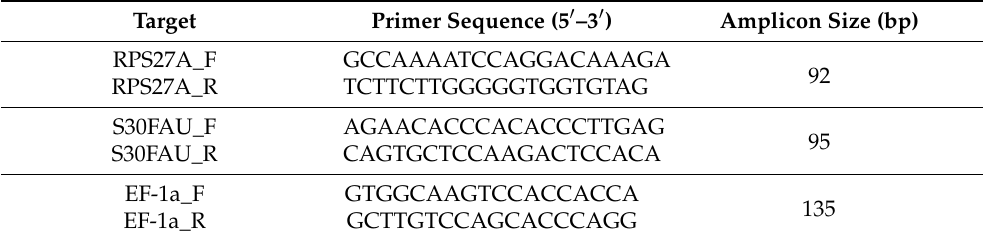
Table 1. PCR primers used in this